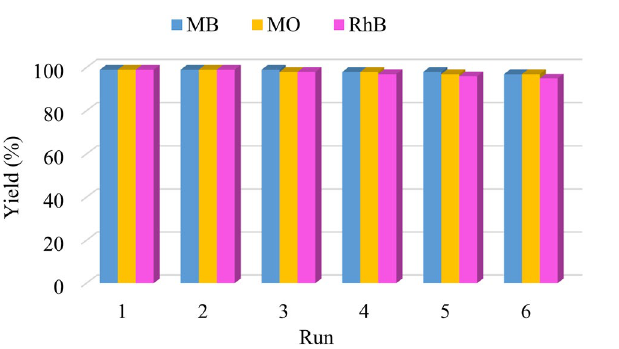
Figure 14. Reusability diagram of KIT-5-biguanidine-Au (0) Nanocatalyst for reduction of MB, MO and